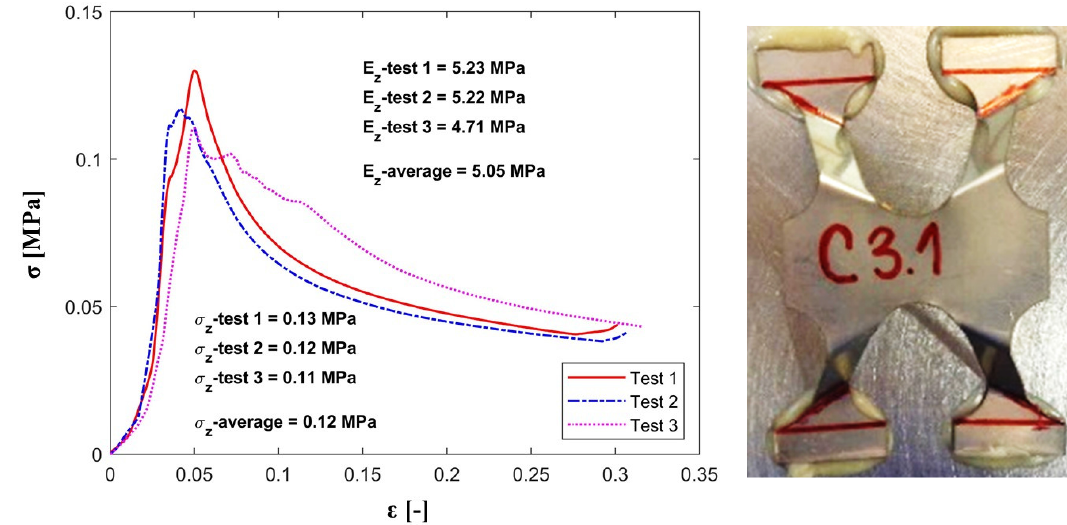
Figure 7. Stress-strain plot for the C2 configuration under out-of-plane compression.